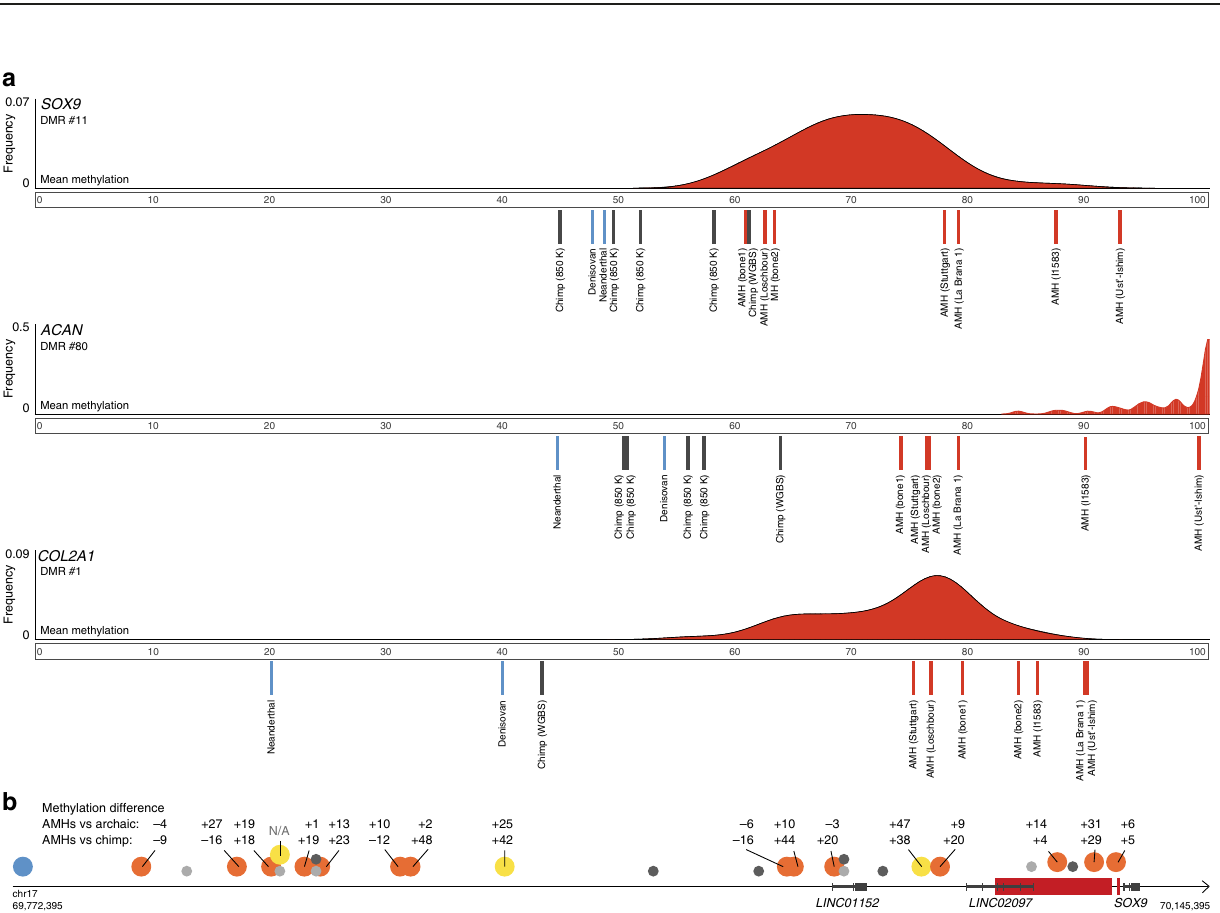
Fig. 4 Hypermethylation of SOX9 , ACAN , and COL2A1 in AMHs. a Methylation levels in the AMH-derived DMRs in SOX9 , ACAN , and COL2A1 . AMH samples are marked with red lines, archaic human samples are marked with blue lines and chimpanzee samples are marked with gray lines. The distribution of methylation across 52 AMH samples (450K methylation arrays) is presented in red. b SOX9 and its upstream regulatory elements. AMH-derived DMRs are marked with red rectangles. Previously identi fi ed putative enhancers are marked with circles: human craniofacial (orange), human craniofacial, chimpanzee-biased (blue), human skeletal (yellow), human non-skeletal (dark gray), and mouse (light gray). Numbers above skeletal enhancers show the difference in mean bone methylation between AMHs and archaic humans (top) and between AMHs and chimpanzee (bottom). Across almost all SOX9 enhancers, AMHs are hypermethylated compared to archaic humans and the